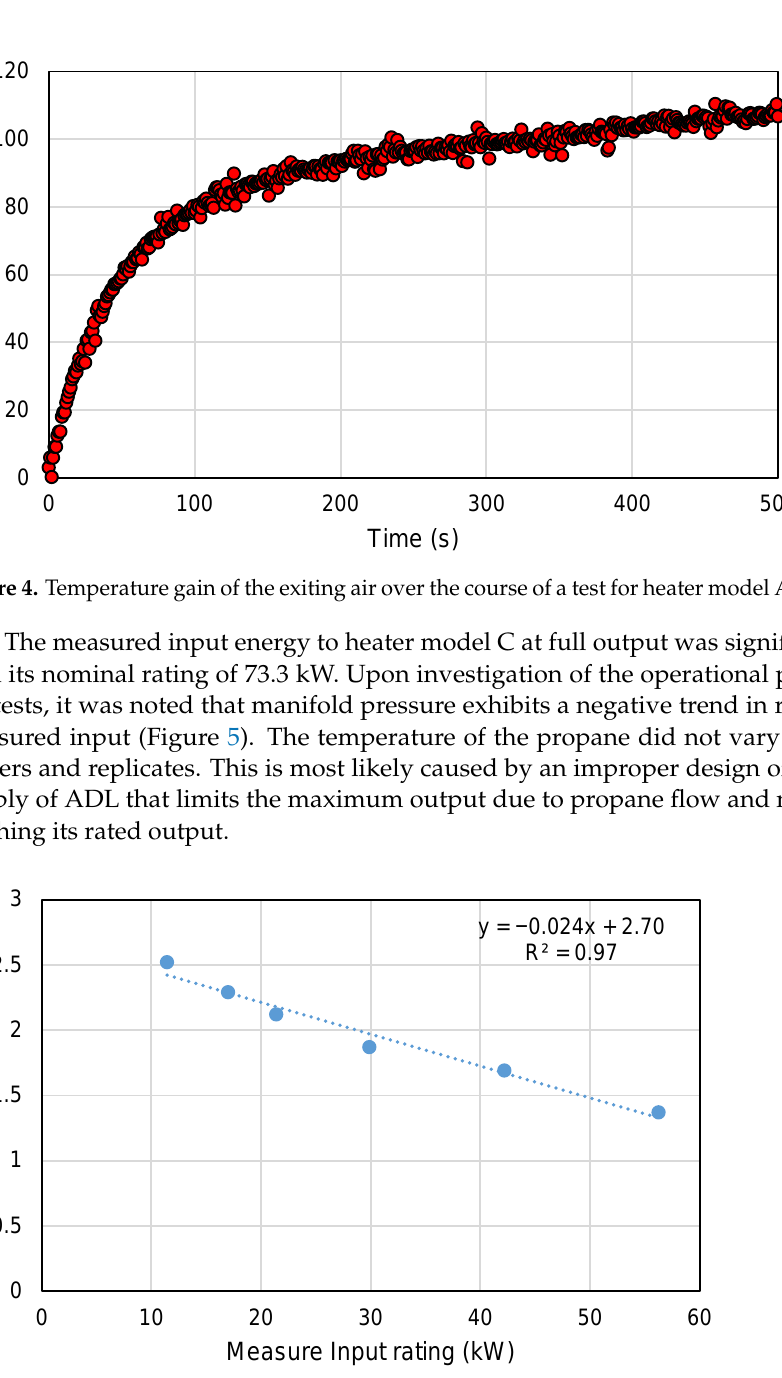
Figure 5. Measured input of propane (x-axis) versus the manifold propane pressure (y-axis).